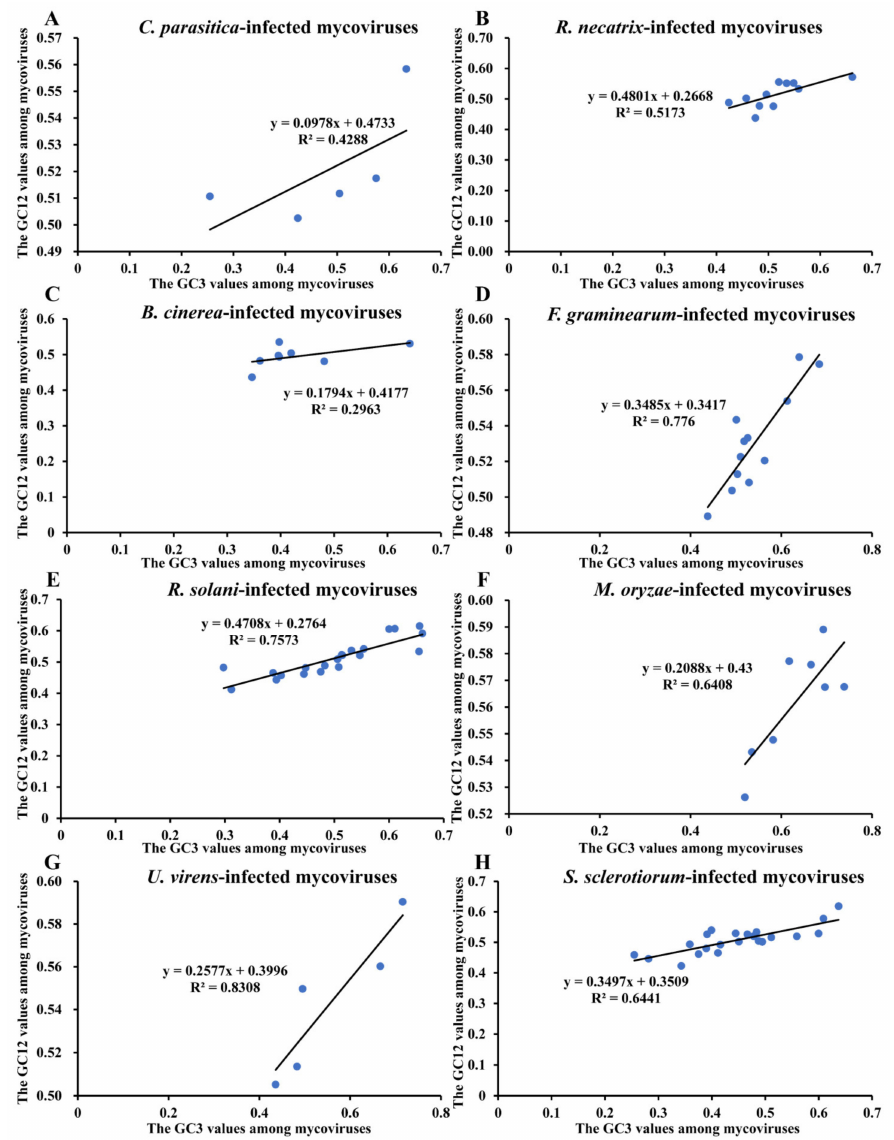
Figure 4. The neutrality plot analysis. The x -axis represents the GC3 (GC values at the third position of codons) values of mycoviruses, and the y -axis represents GC12 (the average of GC values at the first (GC1) and second (GC2) positions of codons) values of mycoviruses. The solid lines represent the correlation line, and the correlation curve equations are shown on the plot. Each blue dot represents one mycovirus. ( A – H ) represent the neutrality plot analysis of mycoviruses that infected C. parasitica , R. necatrix , B. cinerea , F. graminearum , R. solani , M. oryzae , U. virens , and S. sclerotiorum ,